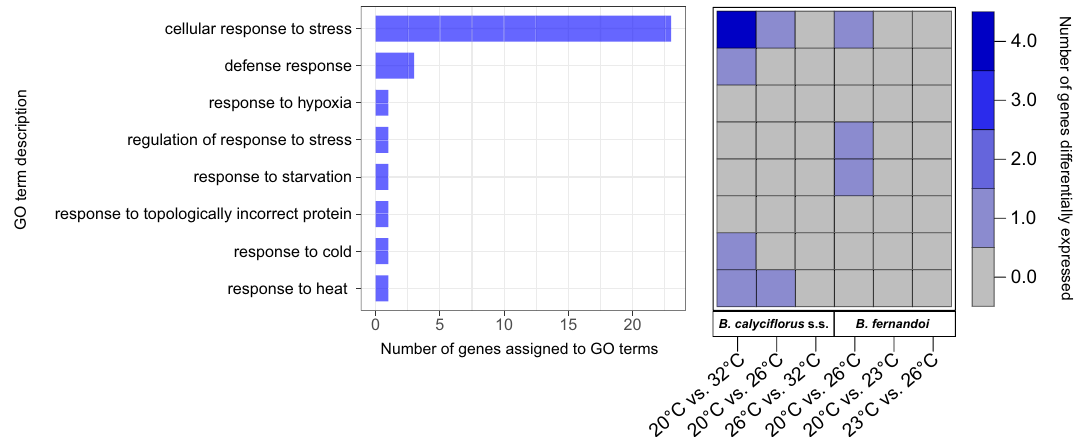
Figure 1. Annotation and differential expression of genes inferred to be under positive selection. Bar plot shows the genes which were assigned to the term GO:0006950 (response to stress). Bars represent the number genes assigned to one of the child terms of GO:0006950. More than one GO term can be assigned to the same gene. The heatmap shows the number of genes differentially expressed in each GO term category in B. calyciflorus s.s. and B. fernandoi under different temperatures regimes 35 .